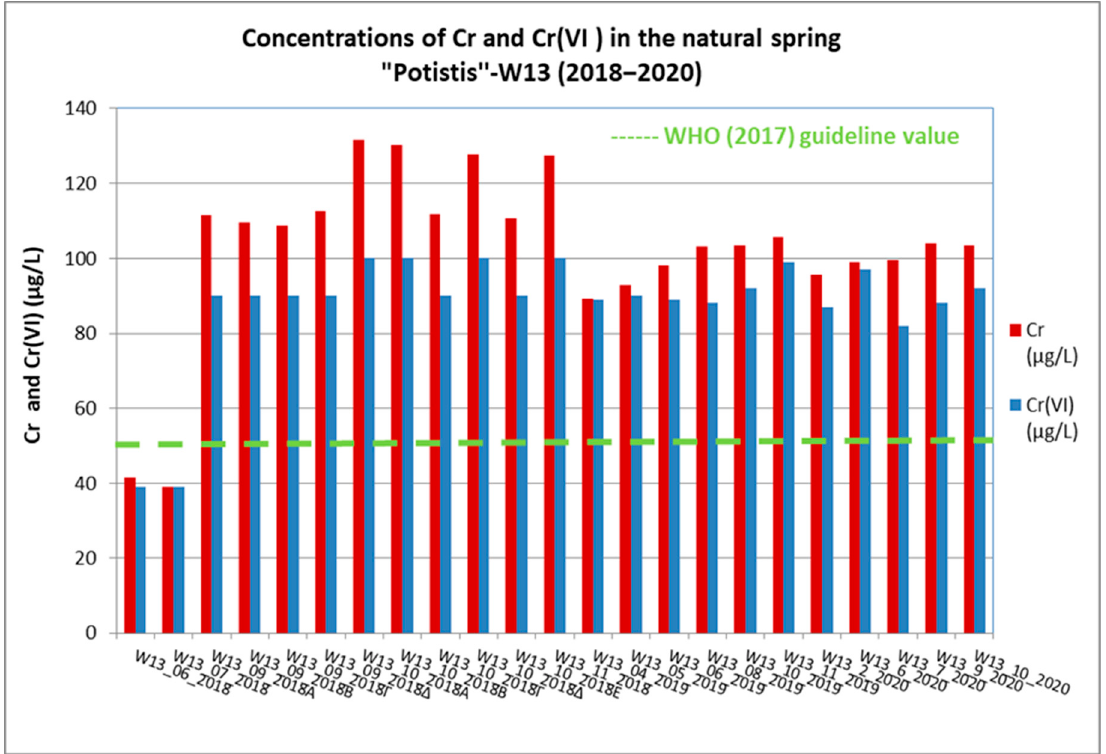
Figure 10. Concentrations of Cr and Cr(VI) in the natural spring “Potistis” ‒ W13 of western Vermio Mt.